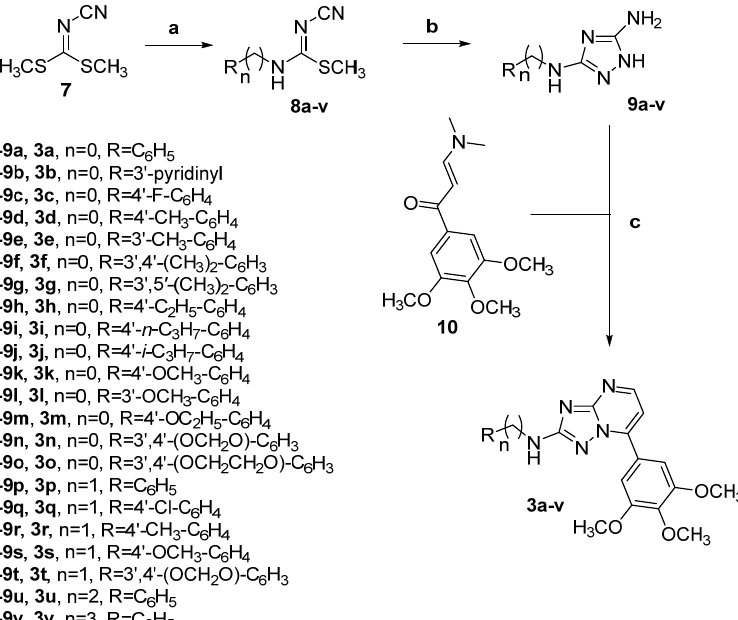
Figure 2. Chemical structures of newly synthesized compounds 3a–v based on the 7-(3 ′ ,4 ′ ,5 ′ -tri- methoxyphenyl)[1,2,4]triazolo[1,5- a ]pyrimidine scaffold and general molecular formula 6a–d of